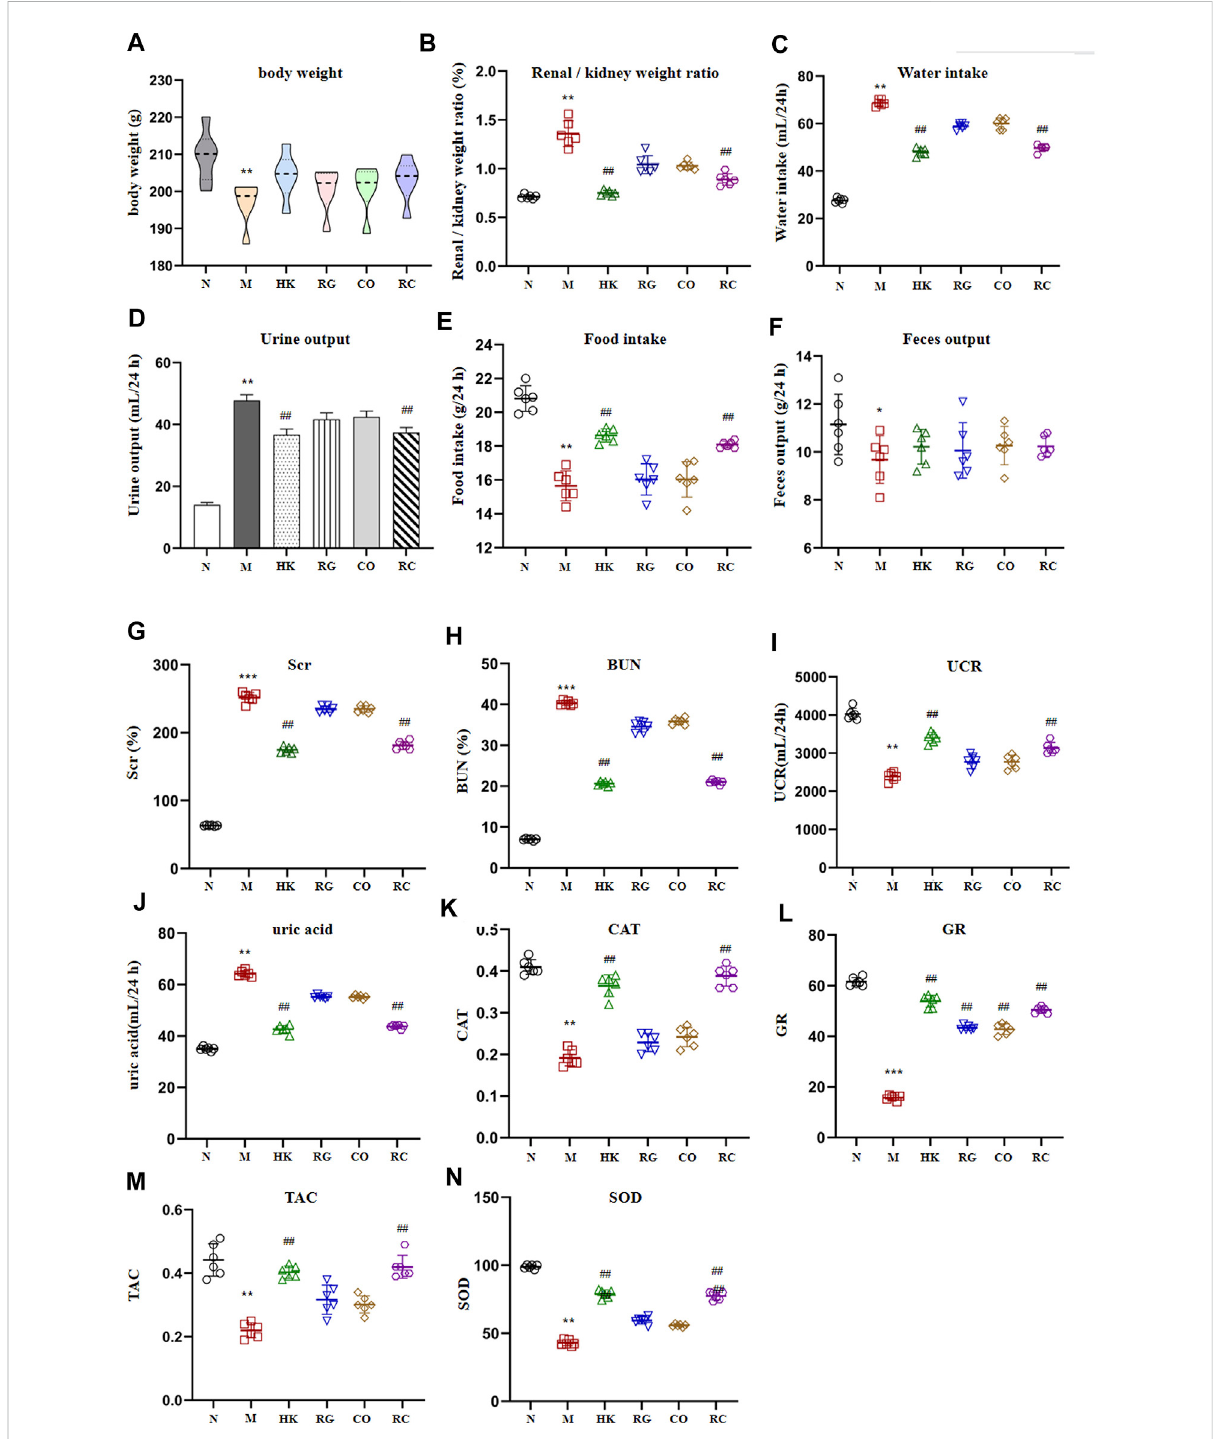
FIGURE 1 Intervention effect of RG, CO, and RC on some physiological parameters: (A) body weight (g), (B) renal/kidney weight ratio (%), (C) water intake (ml/24 h), (D) urineoutput(ml/24 h), (E) foodintake(g/24 h), (F) fecaloutput(g/24 h), (G) SCr(%), (H) BUN(%), (I) UCR(ml/24 h), (J) uricacid(ml/24 h), (K) CAT, (L) GR, (M) TAC, and (N) SOD. (Data are means ± SD. *** p < 0.001, ** p < 0.01, and * p < 0.05 vs . normal group; ## p < 0.01, and # p < 0.05 vs . model group. n =